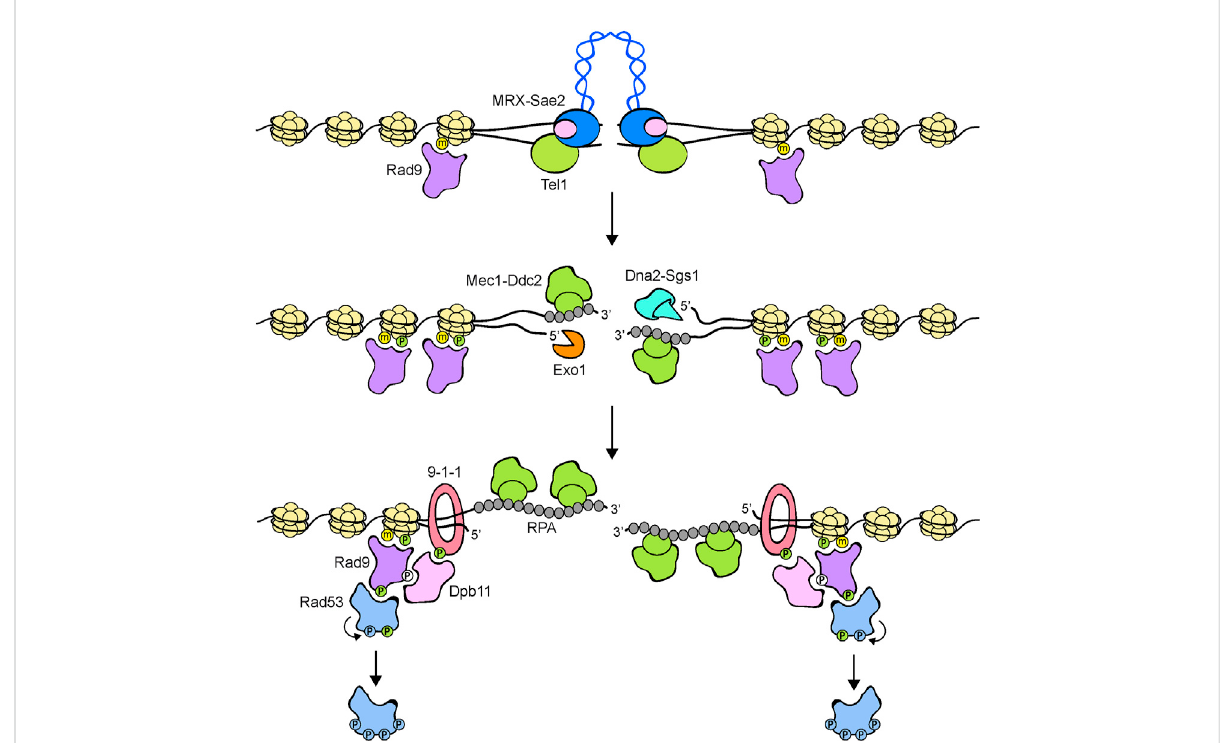
FIGURE 3 Model for Rad53 activation in response to DNA DSBs. The MRX-Sae2 complex is rapidly recruited to DNA ends. Rad9 is already bound to chromatinviainteractionwithmethylatedhistoneH3(yellowdots).MRXboundtoDNAendsrecruitsandactivatesTel1,whichinturnphosphorylates histoneH2AonS129(greendots),aneventthatleadstoafurtherenrichmentofRad9atDSBs.DSBendprocessingbyExo1andDna2-Sgs1nucleases generatesssDNAthatiscoatedbyRPA.RPA-coatedssDNAallowstherecruitmentofMec1-Ddc2andaswitch fromTel1toMec1signaling.The 9-1-1clamploaderrecruitsthe9-1-1complexatthe5 ′ recessedendofthessDNA-dsDNAjunction.Mec1inturnphosphorylatestheDdc1subunitof the 9-1-1 complex (green dots), thus creating a docking site for Dpb11 binding. Rad9, once phosphorylated by Cdk1 (white dots), can also bind to Dpb11 that acts as a scaffold to promote Rad9-Mec1 interaction and therefore Rad9 phosphorylation by Mec1. Phosphorylated Rad9 fi rst acts as an adaptor to bring Rad53 into close proximity to Mec1 to allow Mec1-dependent Rad53 phosphorylation. Then, Rad9 promotes Rad53 in trans- autophosphorylation (light blue dots) by increasing the local concentration of Rad53 molecules. Fully activated Rad53 molecules are then released from the Rad9 complex. Rad9 oligomerization is not